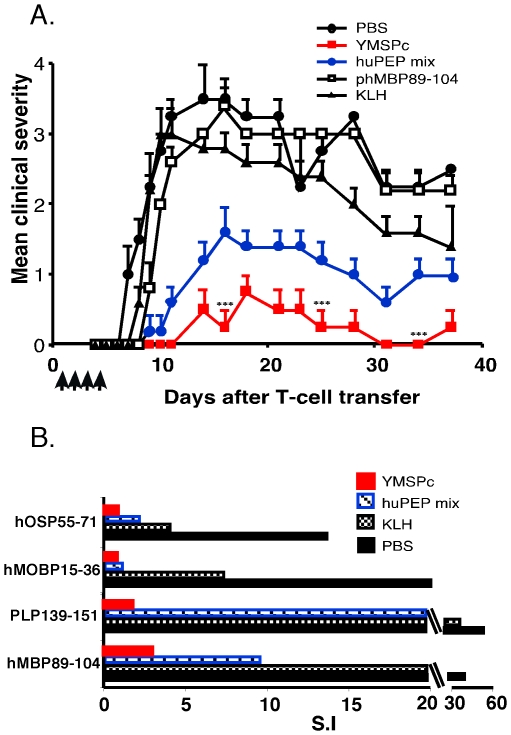
Y-MSPc is more efficacious than peptide cocktail (huPEP mix) in suppressing passively transferred “complex EAE” and in concomitantly downregulating multiple pathogenic anti-myelin T-cells.“Complex EAE” associated with multiple pathogenic anti-myelin T-cell autoreactivities was passively transferred to BSF1 mice with a pool of five activated encephalitogenic T-cell lines: Recipient mice were injected i.v. with 0.5 ml PBS containing phMBP89-104-specific line T-cells (0.5×106), phPLP139-151-specific line T-cells (0.5×106), phMOG34-56-specific line T-cells (0.7×106), phMOBP15-36-specific line T-cells (0.8×106), and phOSP55-74-specific line T-cells (0.5×106). Each of the individual T-cell lines is highly encephalitogenic (Table S1). (A) Efficacy of Y-MSPc vs. peptide cocktail (huPEP mix), as ‘multi-epitope targeting’ agents, in suppressing passively transferred “complex EAE”. Recipients of the pool of encephalitogenic T-cell lines were injected i.v. daily, from days 1 to 4 after transfer, with phMBP89-104 (75 µg), a mixture of the 5 relevant peptides at equivalent amounts (huPEP mix, 150 µg total), Y-MSPc (100 µg), KLH (100 µg) as negative control, or with PBS, and followed for the development of clinical signs of EAE. (B), Y-MSPc suppression of passively transferred “complex EAE” is associated with concomitant downregulation of each of the multiple encephalitogenic T-cells. Recipients were injected on days 1, 2, 3, and 4 after T-cell transfer with Y-MSPc (100 µg), KLH (100 µg), huPEP mix (150 µg) in 0.5 ml PBS, or with PBS alone. On day 7, spleen cells were isolated and tested for their proliferative response to each of the relevant five peptides (10 µg/ml). The in-vivo and in-vitro suppression effects presented are from one experiment representative of two (A) or three (B) independent experiments. ***, p<0.0005 compared to PBS control group; two tailed unpaired Student's t-test.